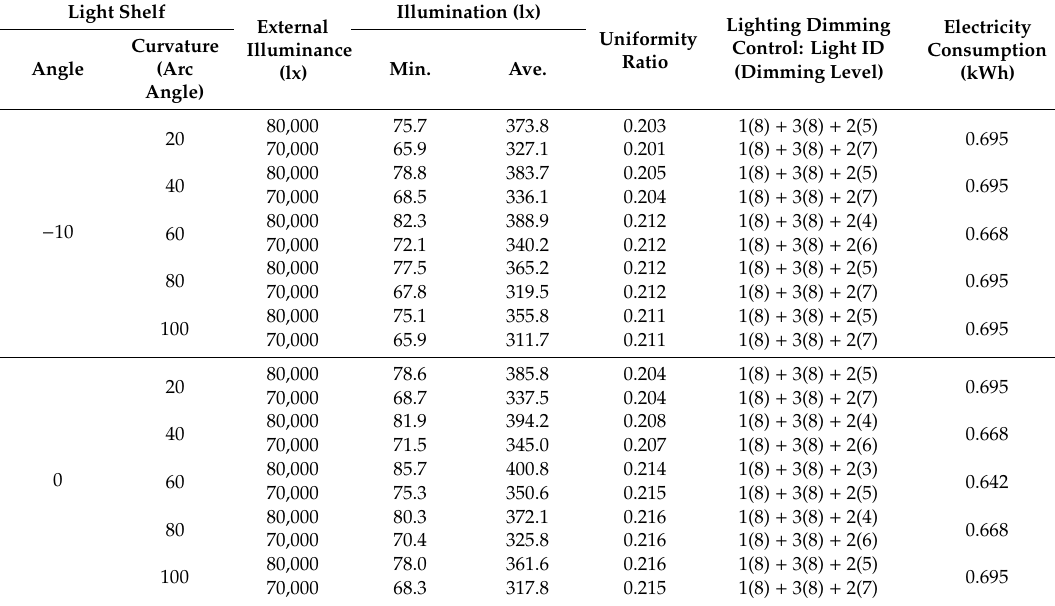
Table 8. Performance evaluation results for curved light shelf during